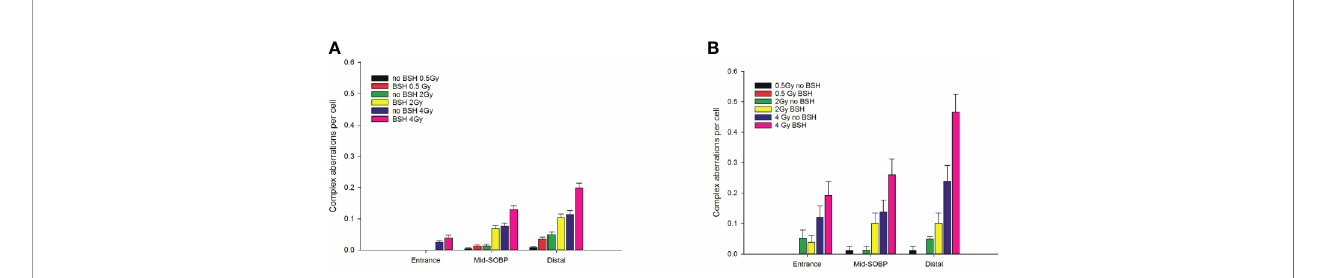
FIGURE 9 | Frequency of complex CA as revealed by WCP, left panel (A) , or mFISH, right panel (B) , as a function of dose and position along the CNAO proton beam SOBP for samples irradiated in the presence or absence